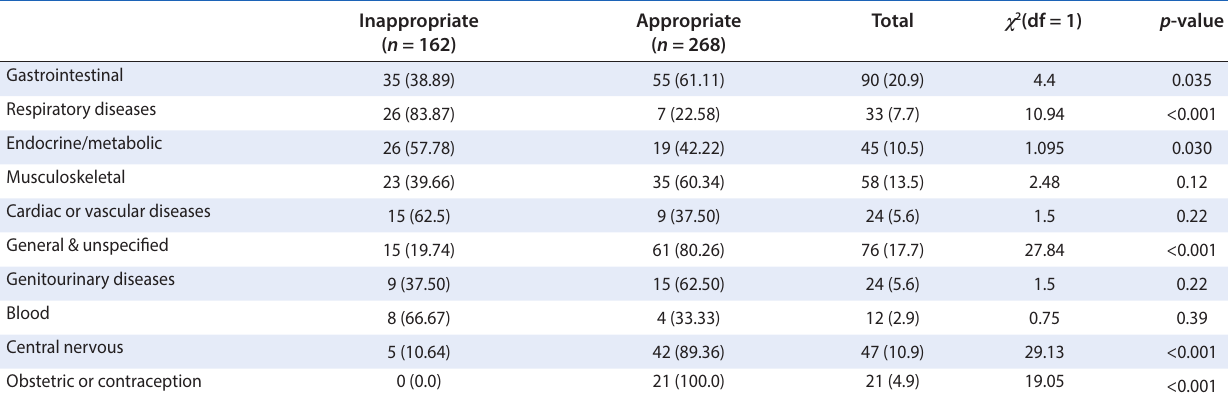
Table 4: Problems diagnosed in AED by ICPC chapter